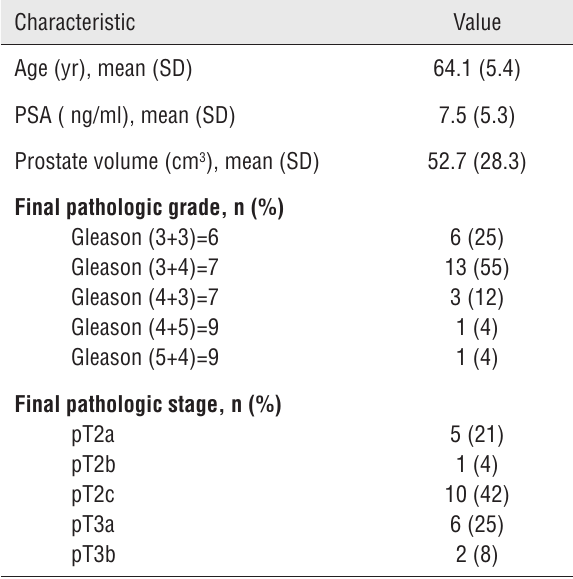
Table 1. clinical and pathologic characteristics of 24 patients with prostate